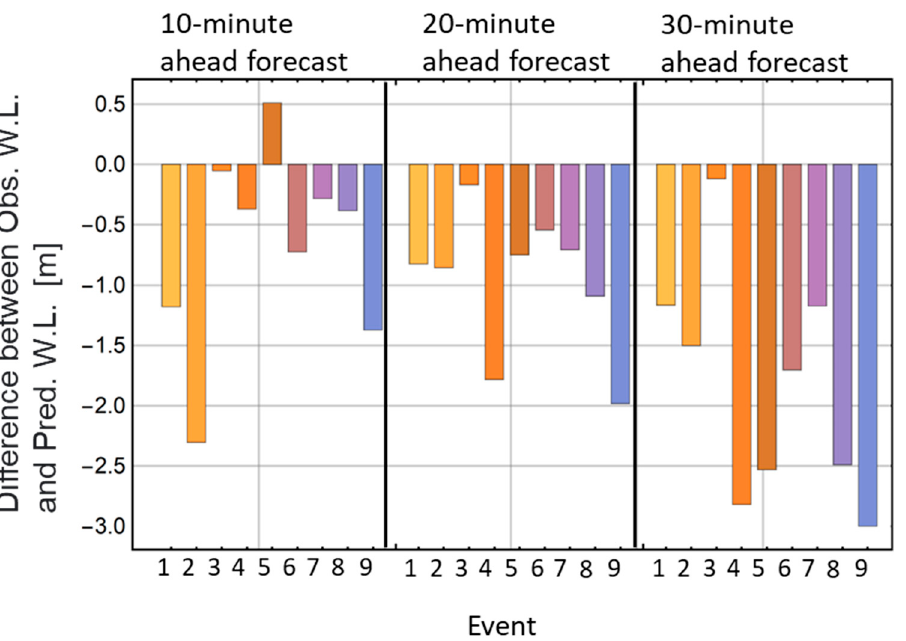
Figure 7. Difference in the observed water level and water level at the peak for each forecast time. The overall accuracy of the 20 min forecast was lower, where the difference in the water level is approximatery1.5 m lower except for the torrential rainfall event 3.